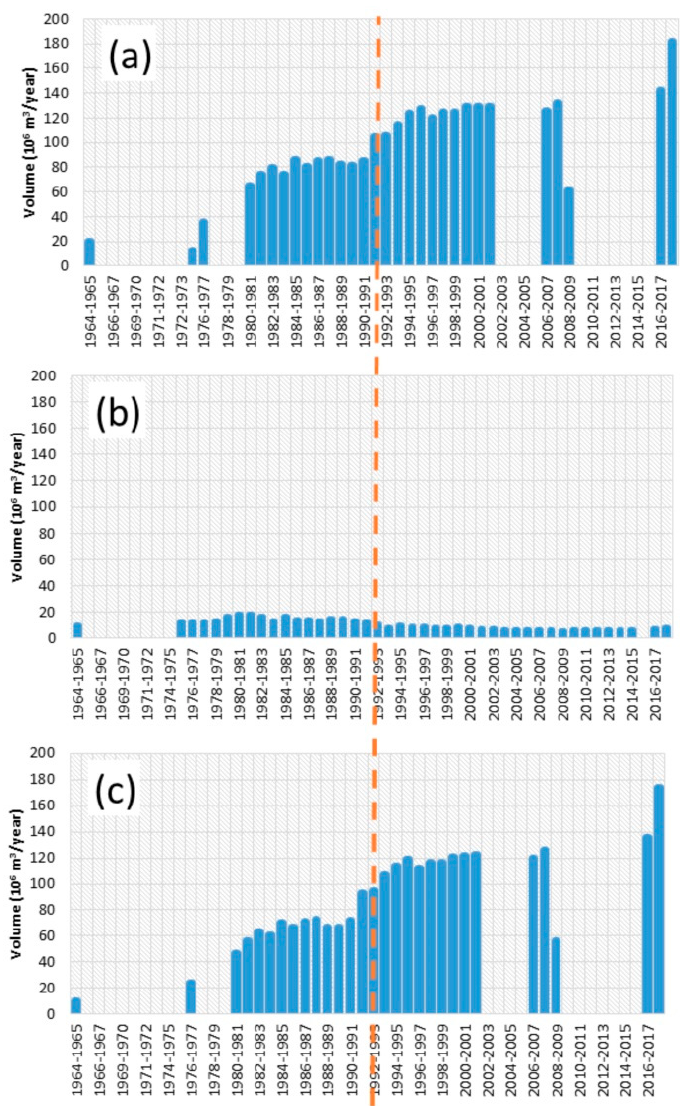
Figure 4. Evolution of groundwater exploitation for ( a ) the whole area of Campo de Dalías, ( b ) shallow aquifers, and ( c ) deep aquifers (in blank: there is no data). The vertical line corresponds to the date that separates the two periods defined, according to the evolution of surface water pumpings. unit (1973) showed elevations of 15 m above sea level (m.a.s.l.). The piezometric